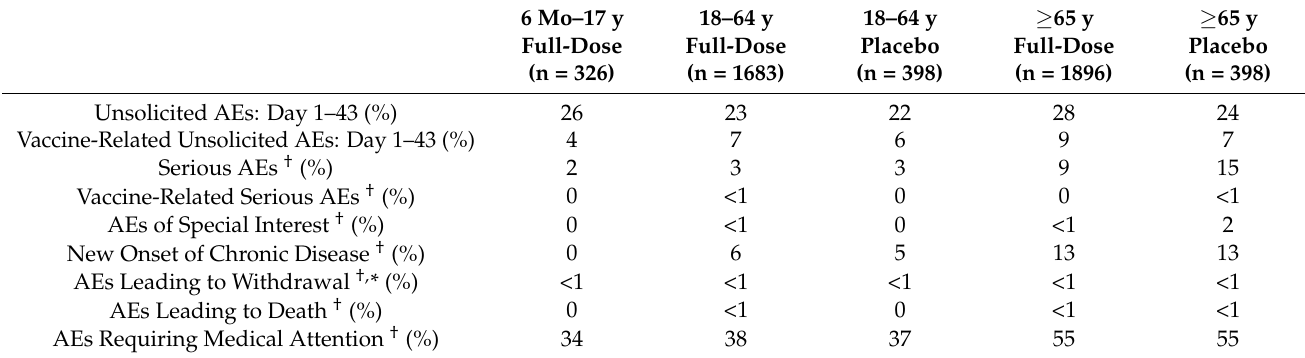
Table 7. Percentages of subjects experiencing unsolicited adverse events following any vaccination.